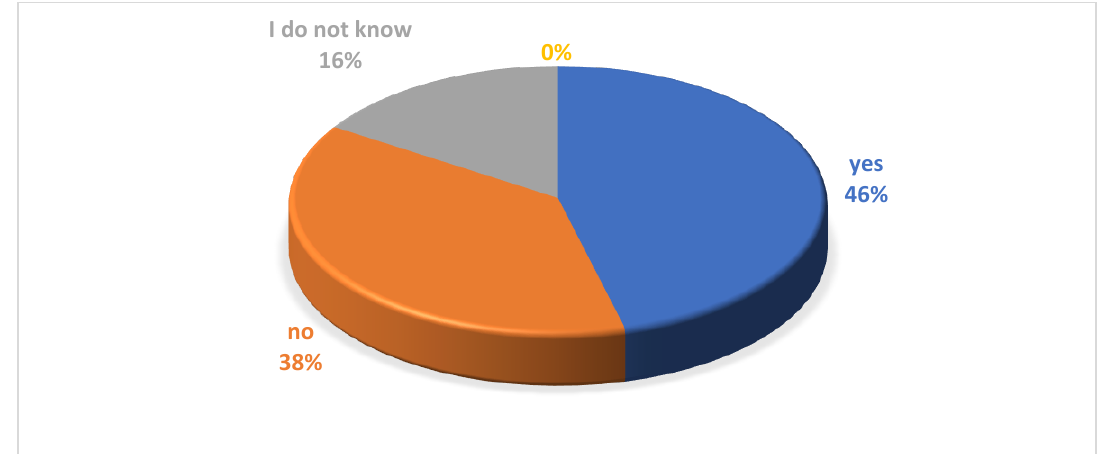
Figure 10. Occurrence of air pollution production with low emissions.